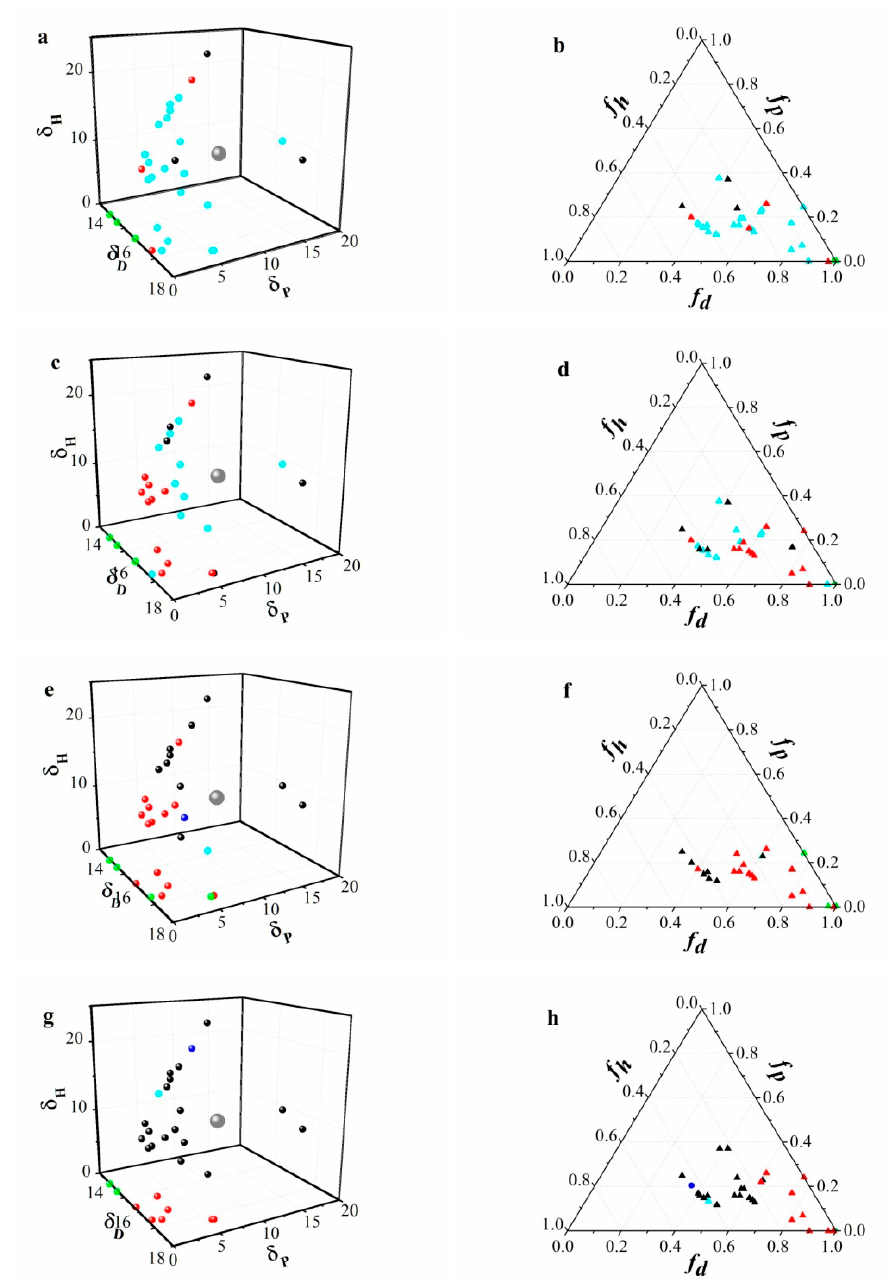
Figure 2. Solubility data for organogelators (compounds 1, 2, 3, and 4) are represented in Hansen space (left) and in Teas plots (right). Blue points represent solution; green spheres indicate the gelator cannot be dissolved in the solvent; cyan spheres indicate the gels cannot be formed at low concentrations ( ≤ 3.0 wt%); red and black points represent the transparent gels and opaque gels, respectively. The center of the gelation sphere and the projection of the sphere on the Teas plot are indicated in gray.